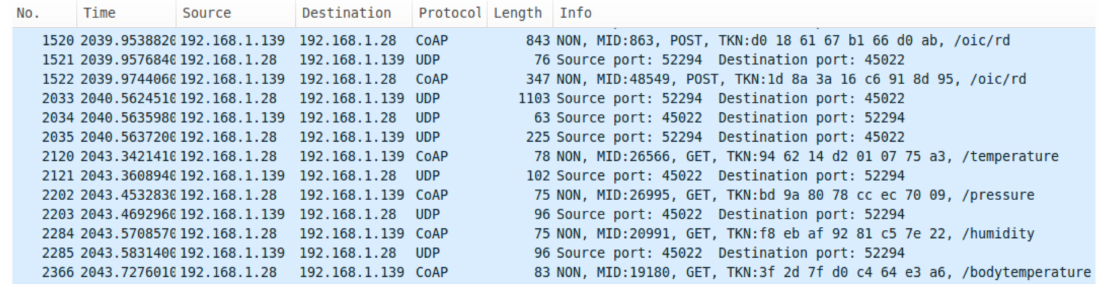
Figure 13. Network packet capture of registration and periodic sensing data collecting.